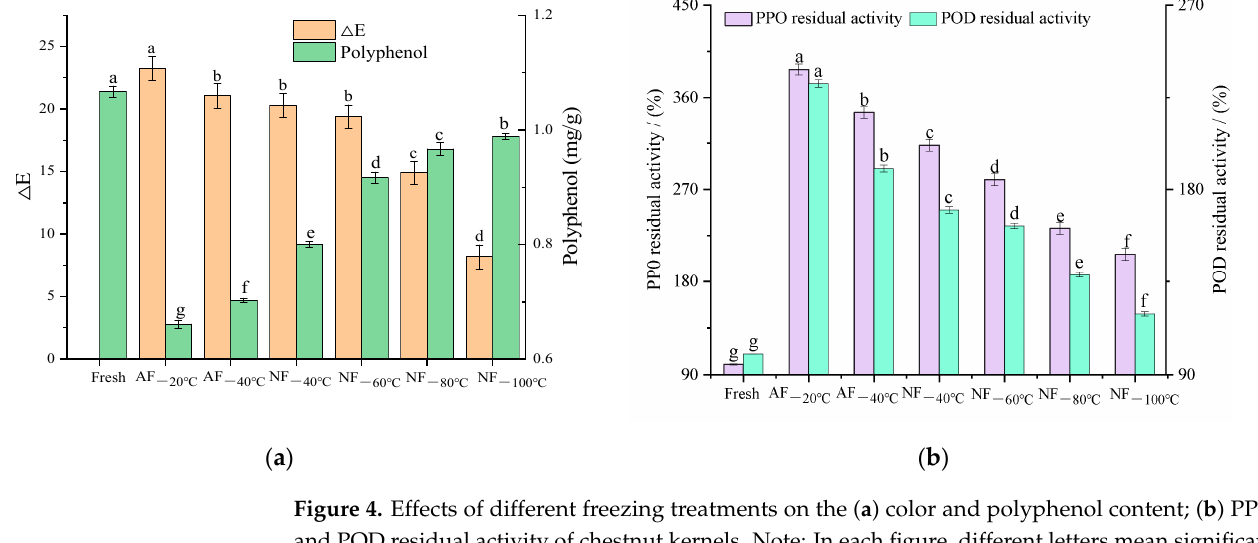
Figure 4. E ff ects of di ff erent freezing treatments on the ( a ) color and polyphenol content; ( b ) PPO Figure 4. Effects of different freezing treatments on the ( a ) color and polyphenol content; ( b ) PPO and POD residual activity of chestnut kernels. and POD residual activity of chestnut kernels. Note: In each figure, different letters mean significant differences ( p <